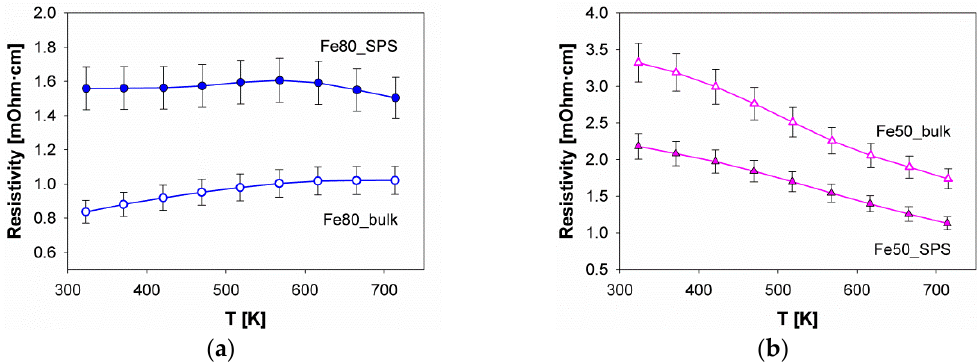
Figure 9. The trend of the electrical resistivity as a function of temperature for sample ( a ) Fe80 and ( b ) Fe50. The curves fitting experimental points are splines.